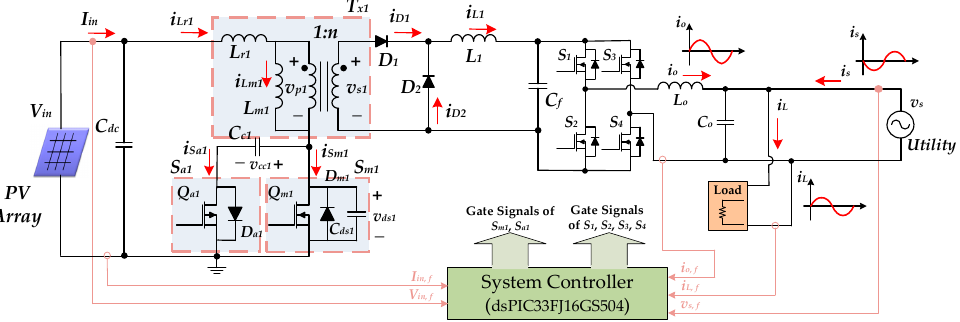
Figure 7. The circuit diagram of a grid-connection power system using the proposed active-clamp forward inverter.